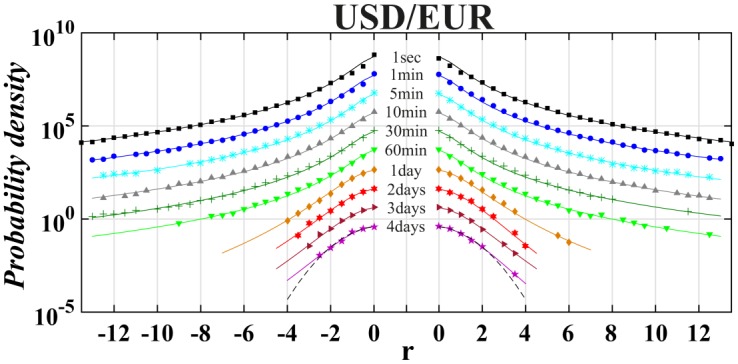
Same as in Fig 10 for USD/EUR exchange rate.